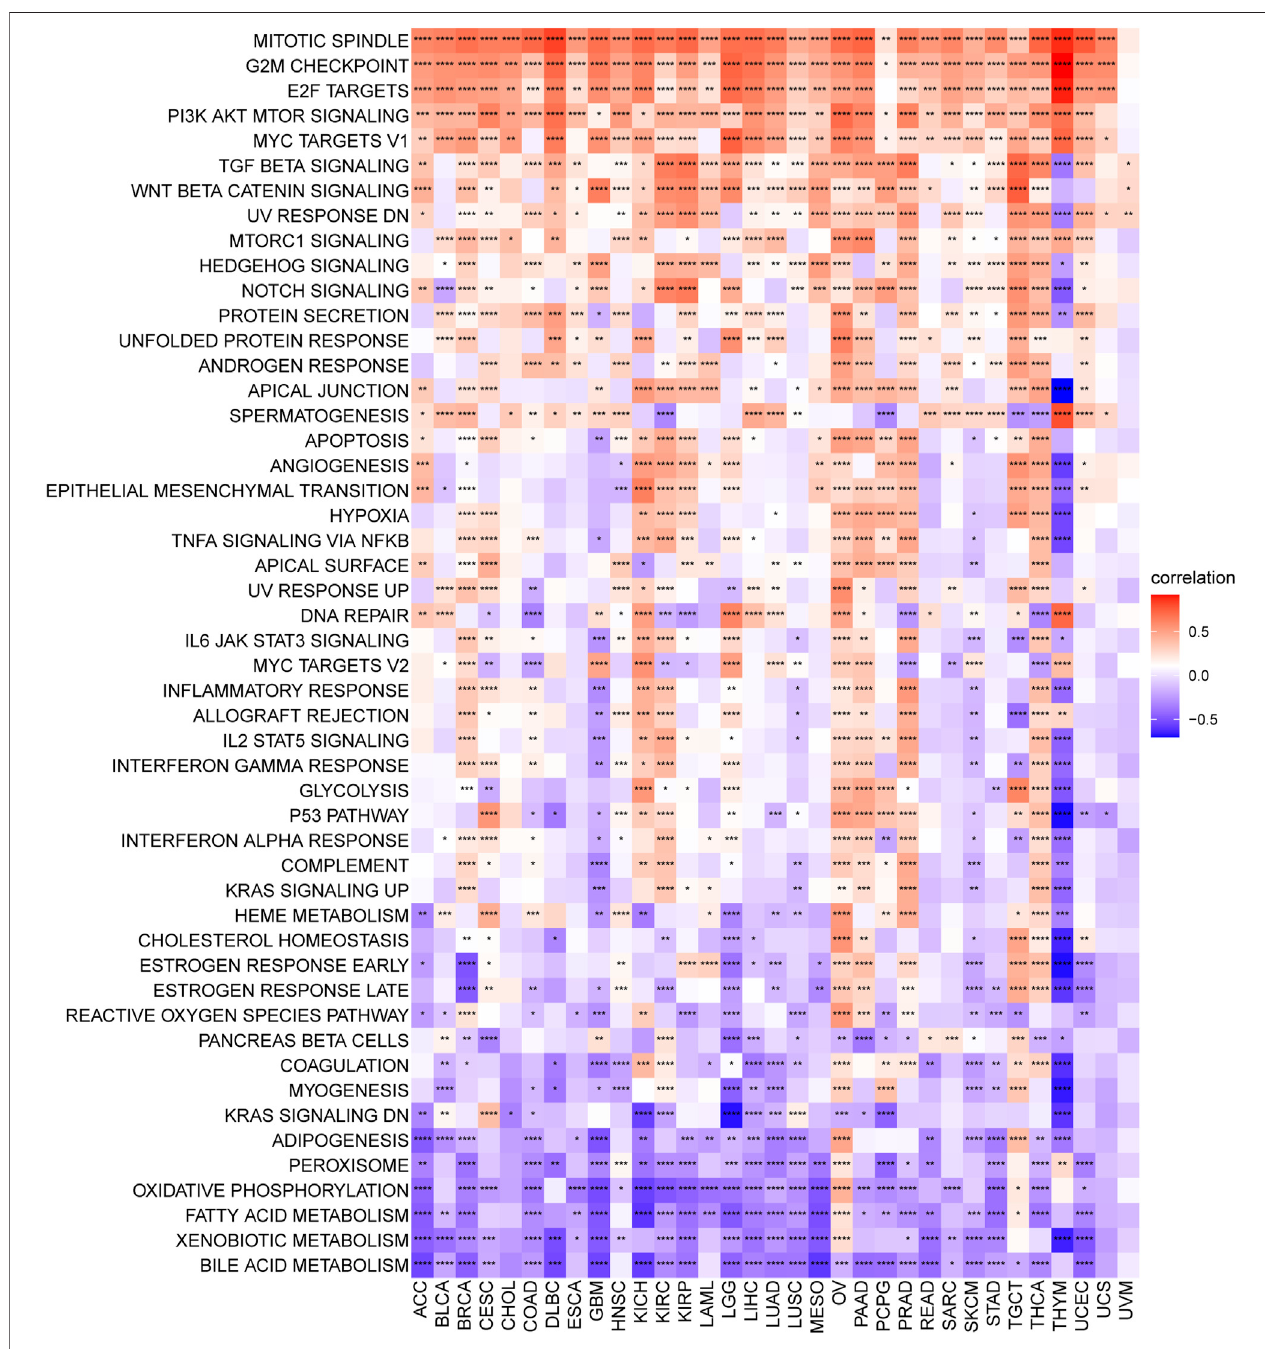
FIGURE 9 | Senescence score correlates hallmark pathways in cancer. Heatmap showing the enrichment of signi fi cant hallmarks sets. Each column indicates a tumor type, and each row indicates a hallmark set. Red indicates a positive correlation, and blue indicates a negative correlation. Darker color indicates stronger correlations (Spearman correlation, p < 0.05 was considered signi fi cant, * p < 0.05, ** p < 0.01, *** p < 0.001, and **** p < 0.0001).